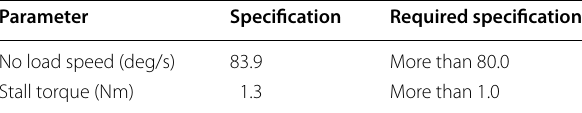
Table 2 Specification and required specification of